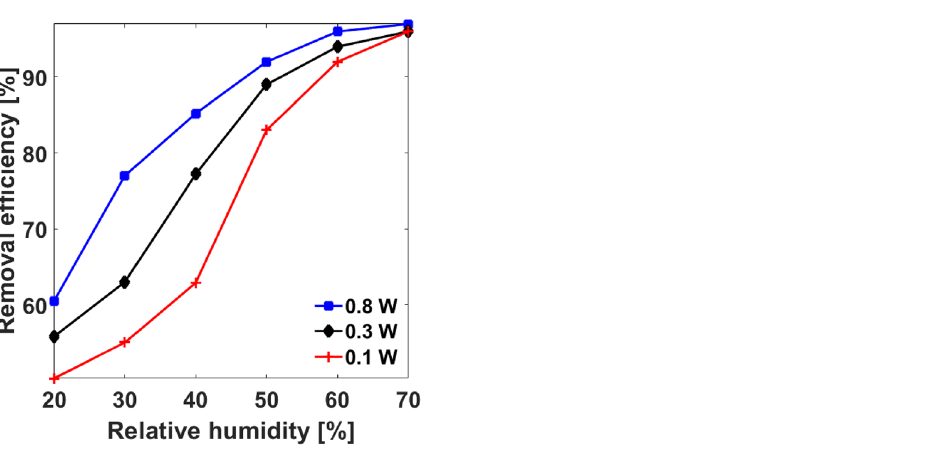
Figure 7. Effect of indoor air humidity on removal efficiency at different discharge power under atmospheric pressure and room